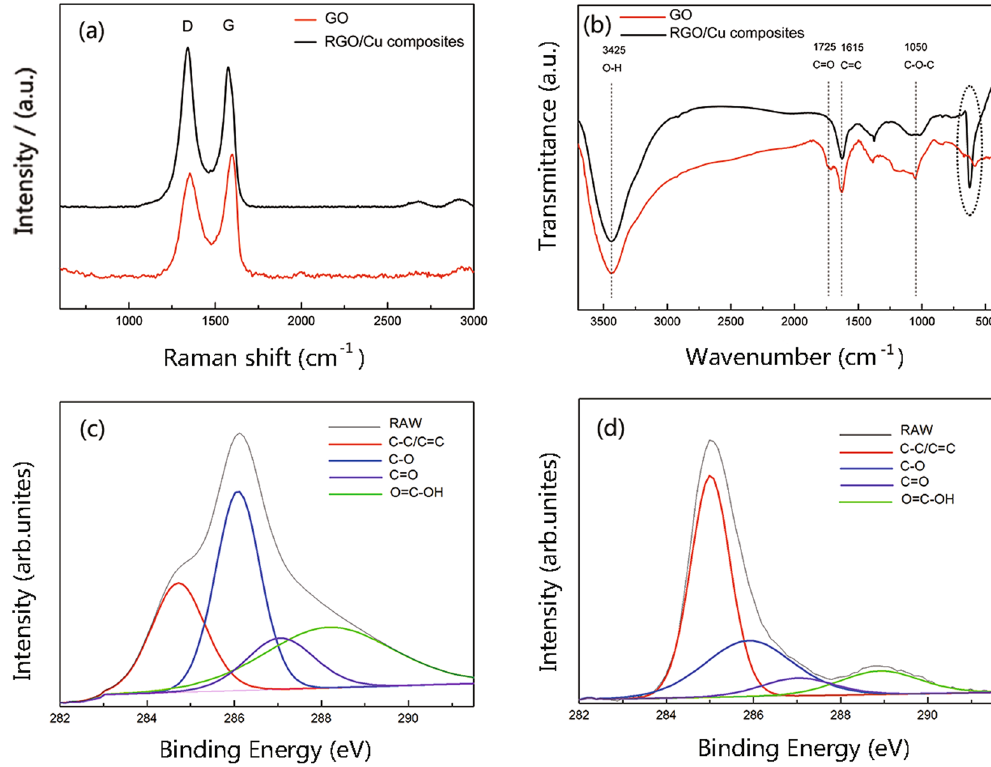
Figure 3. ( a ) Raman spectra and ( b ) FTIR spectrum of as-prepared GO and RGO; Deconvoluted high- resolution C 1 s XPS spectra of ( c ) GO and ( d ) RGO.